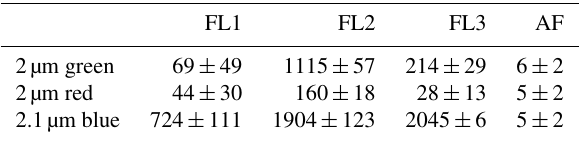
Table 1. Fluorescence and asymmetry factor values of standard PSLs, determined as the peak (mean) of a Gaussian fit applied to a histogram of the signal in each channel. Uncertainties are 1 stan- dard deviation from the Gaussian mean. FL1 FL2 FL3 AF 2µm green 69 ± 49 1115 ± 57 214 ± 29 6 ± 2 2µm